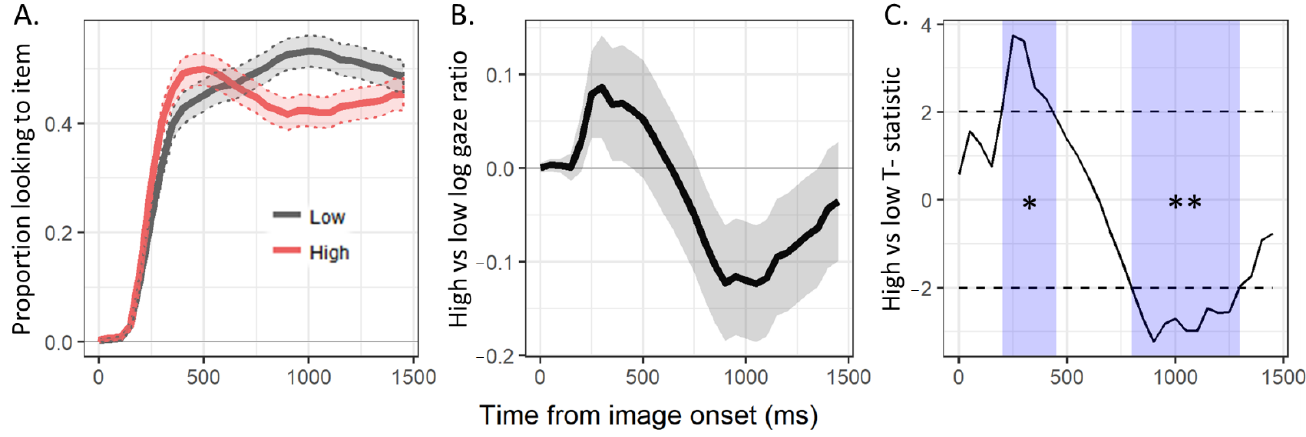
Figure 4. Pre-labeling period time course plots of ( A ) the proportion of fixations to the high (red) and low (grey) items, ( B ) the log gaze ratio of fixations to high vs. low items, and ( C ) the pointwise T-statistics comparing high vs. low items and periods of consecutive significant differences identified by the cluster analysis (light blue), calculated over 50 ms time bins (with SE ribbons). * p < 0.05. ** p < 0.01.